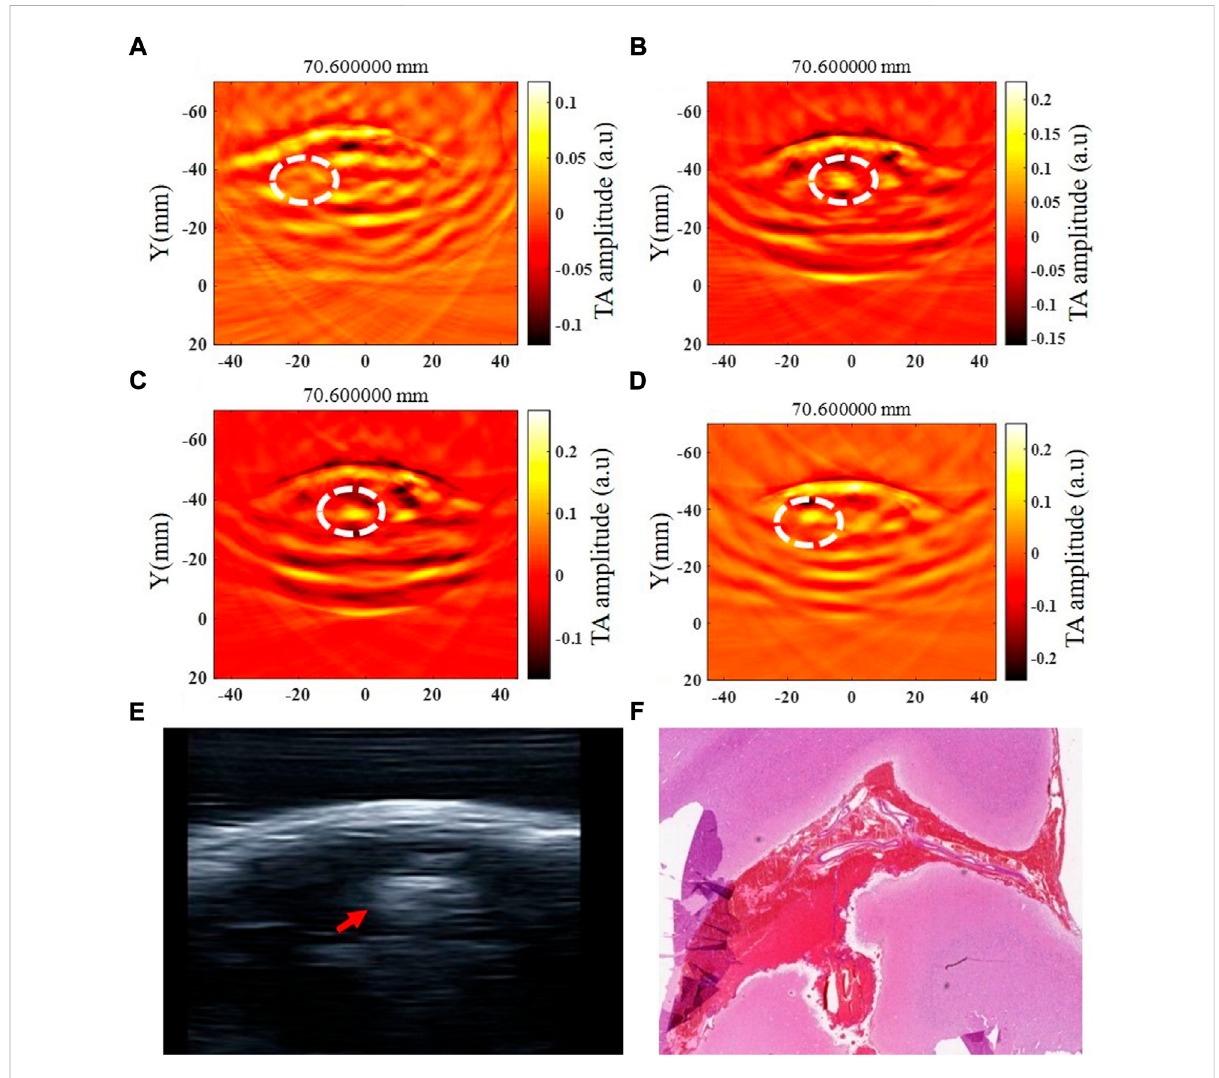
FIGURE 5 Thermoacoustic imaging, ultrasound and pathological examination of a same canine intracerebral hemorrhage. (A – D) TAI images at 0.5 h, 1 h, 3 h and 6 h after modeling, respectively (white circle shows the hemorrhagic area). (E) Ultrasound image of canine intracerebral hemorrhage (white circle shows the hemorrhagic area). (F) Pathological image of canine intracerebral